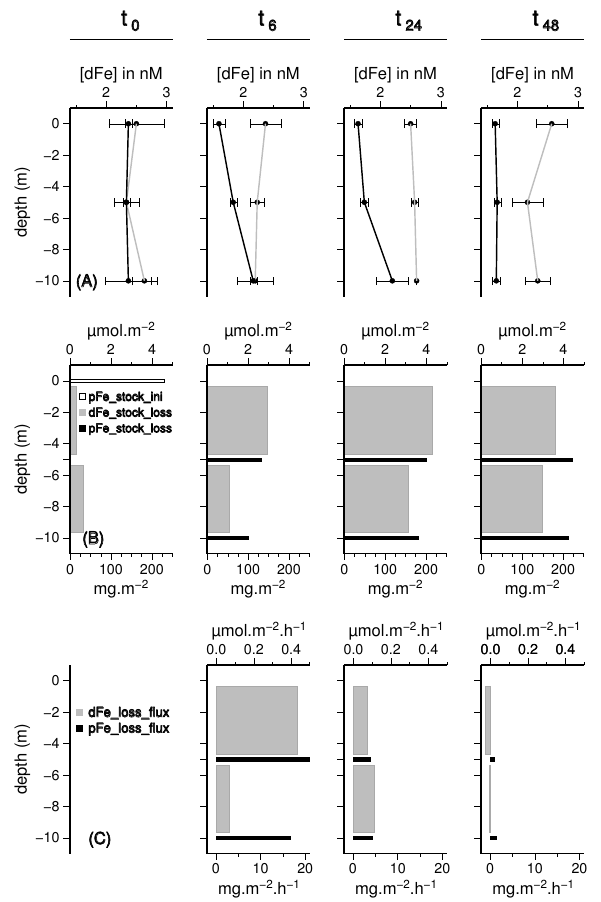
Fig. 5. Scavenging of dissolved iron on settling particles during the first 48h of the DUNE-1-P experiment. All values are the average of the mesocosms triplicates. (a) [dFe] profiles in “CONTROL- meso” (grey line) and “DUST-meso” (black line). (b) Loss of dFe stock (dFe stock loss, Grey bars, top axe – difference between the dFe stock in CONTROL-meso and DUST-meso) and loss of pFe stock (pFe stock loss, black bars, bottom axe, amount of pFe intro- duced by the dust seeding that is lost for the 0–5m layer and the 5–10m layer at time t ). At t 0, the dFe stock loss is due to natural variability in dFe profile in CONTROL-Meso and DUST-Meso. (c) , fluxes of dFe loss (dFe loss flux, Grey bars, top axe) and pFe loss (pFe loss flux, black bars, bottom axe) are the stocks of dFe and pFe lost per unit of time between the different sampling times. The definition and description of the calculation of this parameters can be found in the text (Sect.